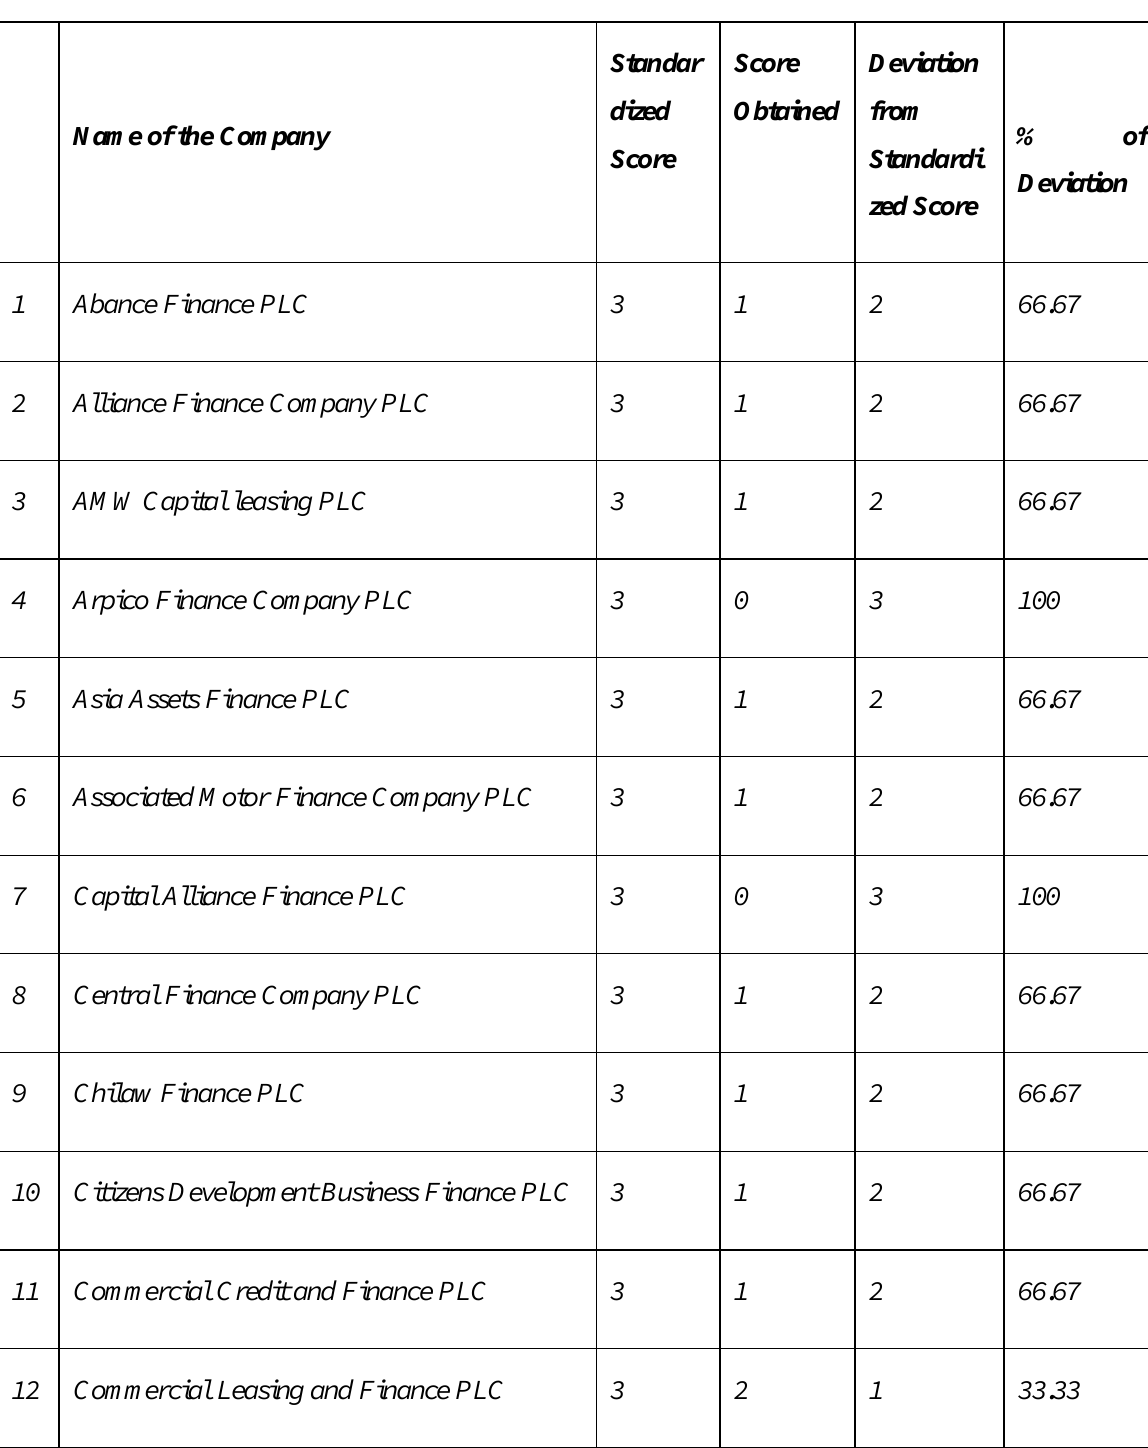
Table 06: Score Board for the compliances as per requirements of paragraph 56 of